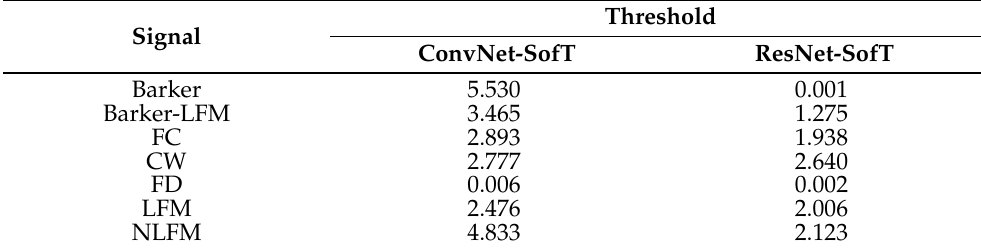
Table 6. Thresholds learned by SofT